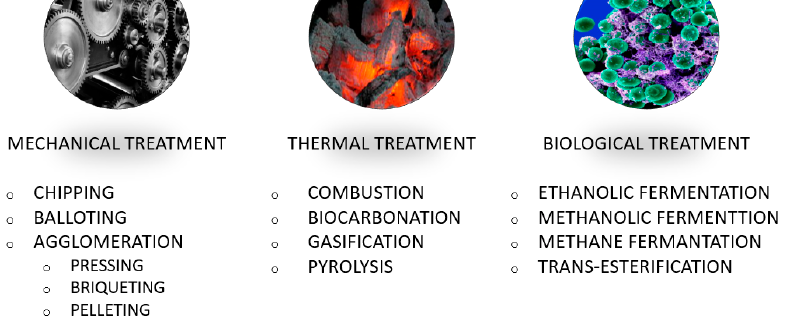
Figure 1. Pre-treatment methods of raw biomass.